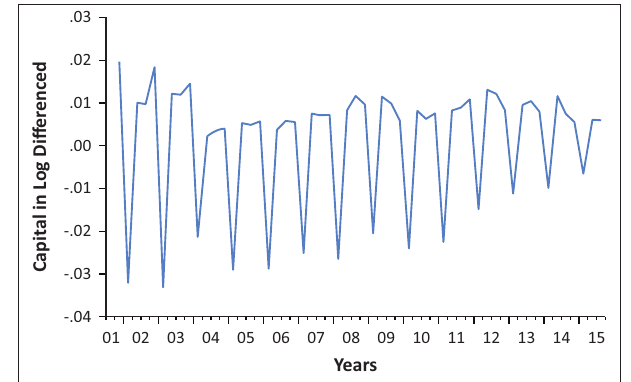
FIGURE 5: Real provincial government and real seasonal adjusted provincial government total capital formation (R’000).